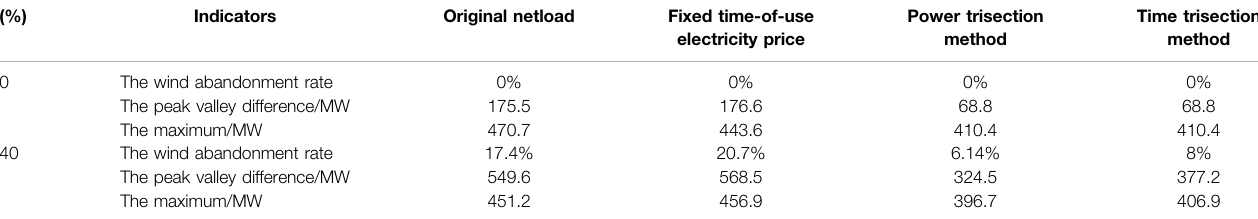
TABLE 1 | Statistics of netload characteristics under different permeability and different time-of-use electricity prices. (%) Indicators Original